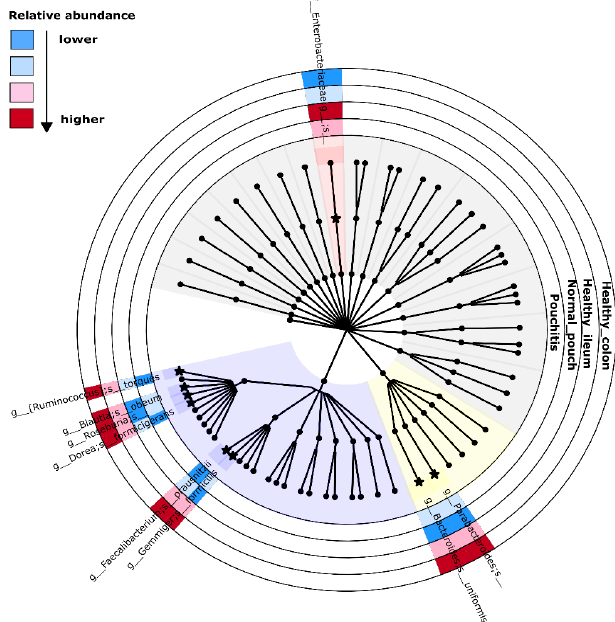
Figure 4. Cladogram for ANCOM significant results. Concentric circles represent the four investi- gated groups. Cladogram has been generated by implementing Graphlan Package on the genus- collapsed taxonomy by QIIME2. Internal nodes: order and family; leaves: genus. Background colors: violet for Clostridiales , yellow for Bacteroidales , red for Enterobacteriales , and grey for remaining groups. Starred nodes and colored sections are relative to ANCOM-relevant taxa: extended taxonomic name is adjacent to nodes, while color interpretation is shown in the top-left part.